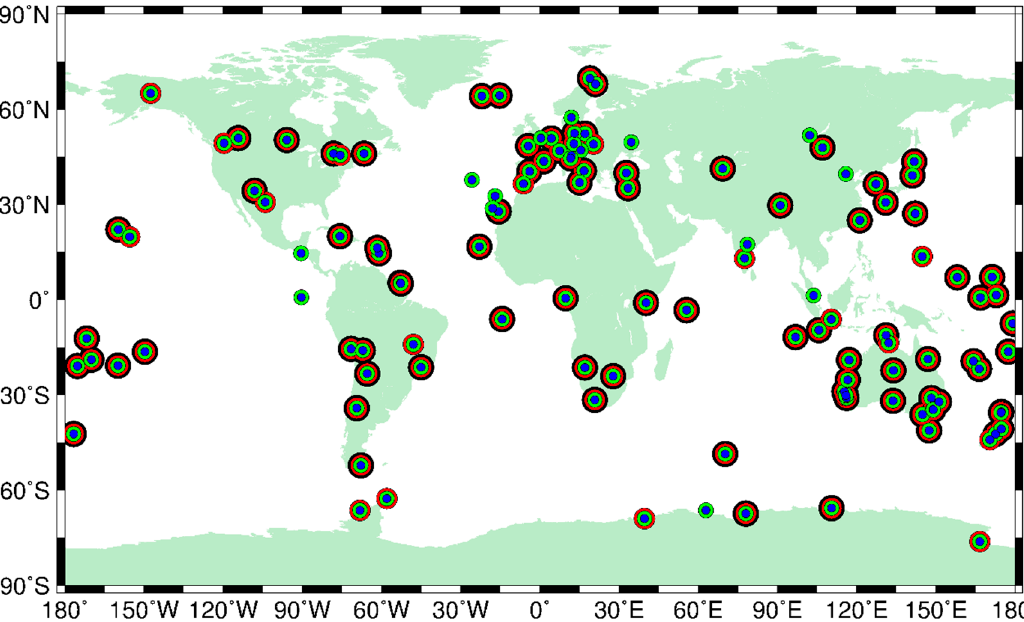
Figure 2. The distribution of global multi-GNSS network used in this study. The colors represent the tracked GNSS systems on a station, GPS in blue, GLONASS in green, Galileo in red and Beidou in black.